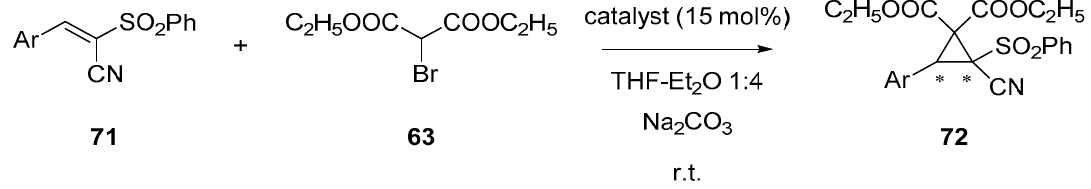
Table 10. Effect of crown ethers in the MIRC reaction of arylidene cyanosulfones 71 and diethyl bromomalonate ( 63 ).